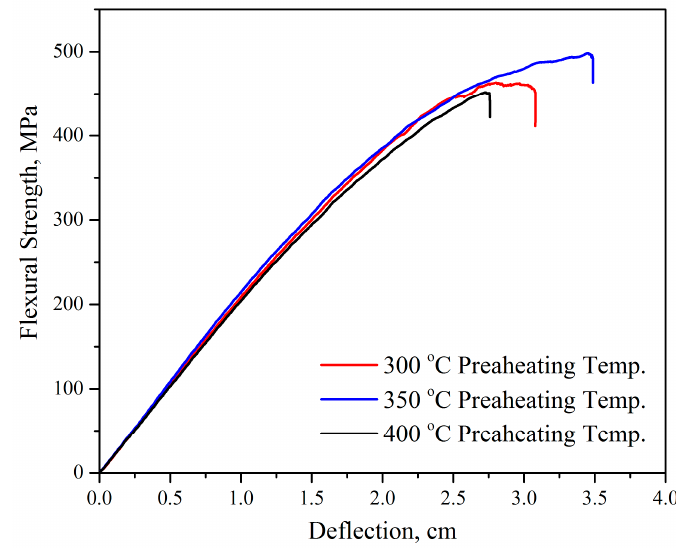
Figure 2. The strain–stress curves of 50 / 50 wt % composites prepared by route 4 using glass fibers (GF) preheated at various temperatures.